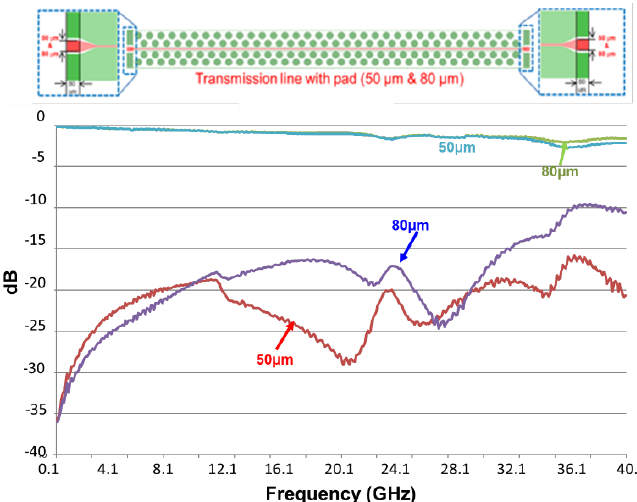
Figure 19. The VNA measurement results of test vehicle (80 µ m pad) and correlation with ANSYS results.